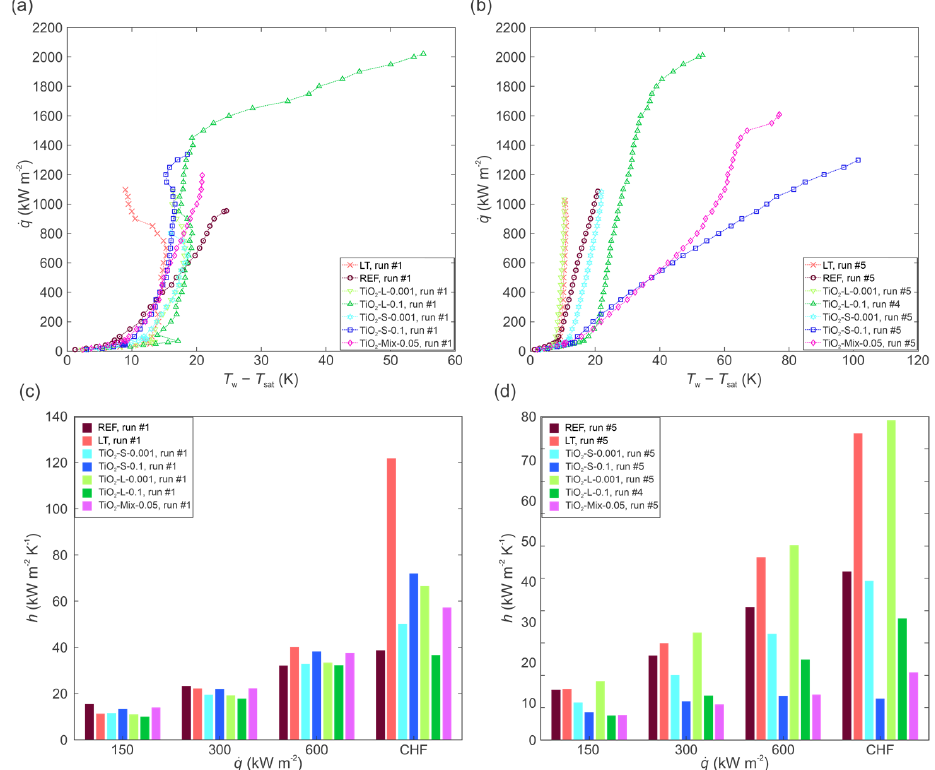
Figure 16. Summary of boiling performance for all tested cases: boiling curves during the first run ( a ) and during the last run ( b ) on each surface; HTC values during the first run ( c ) and during the last run ( d ) on each surface.